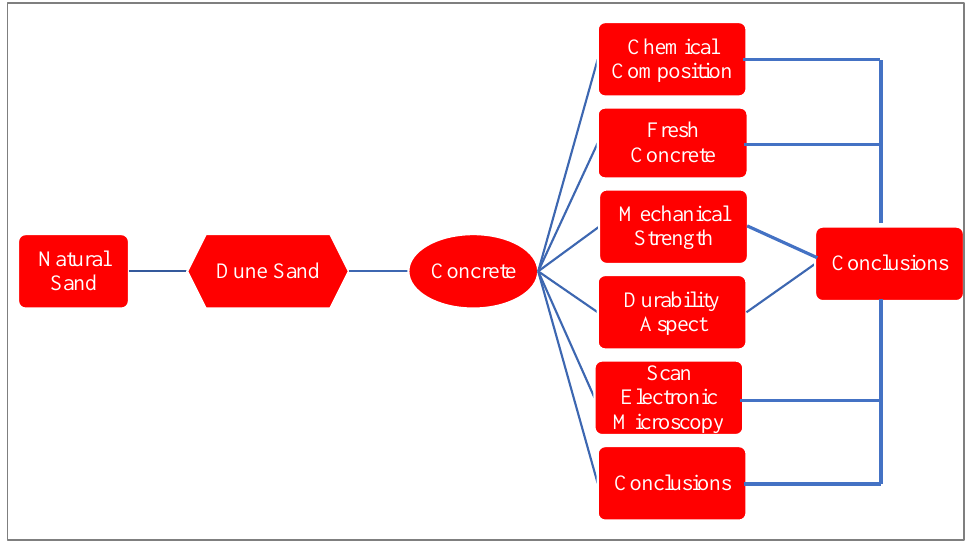
Figure 1. Different sections of the review.